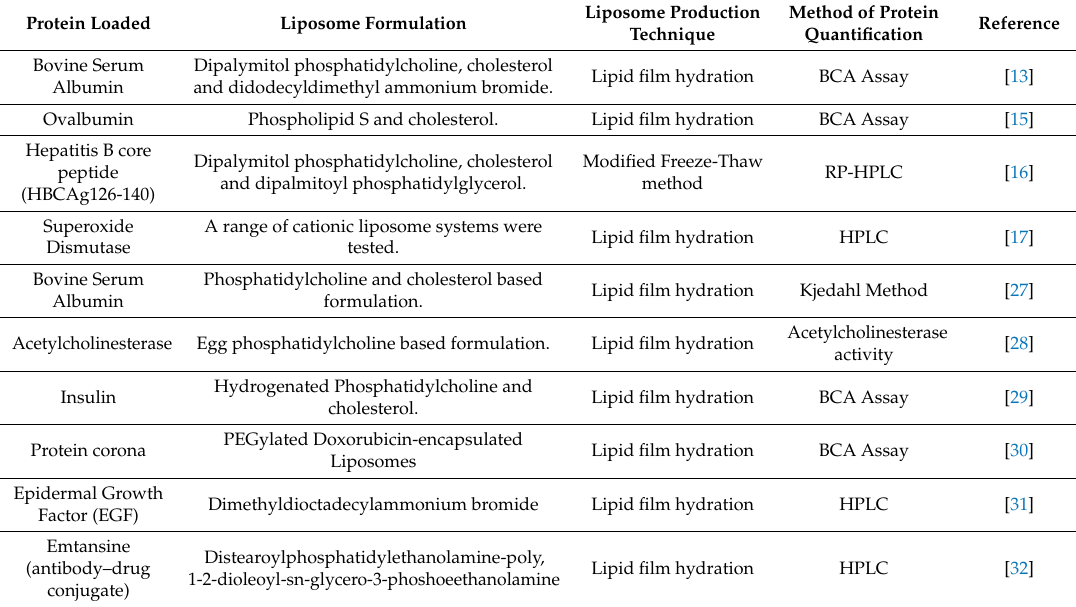
Table 1. Examples of methods used to quantify protein loading in liposomal formulations. Protein